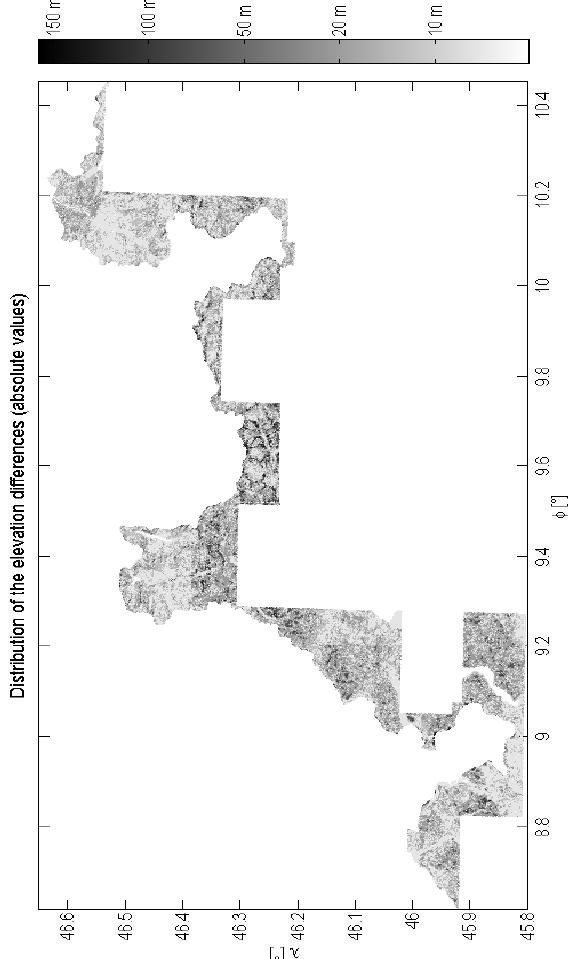
Figure 3. Spatial distribution of the elevation differences between Switzerland and Lombardy DTMs.